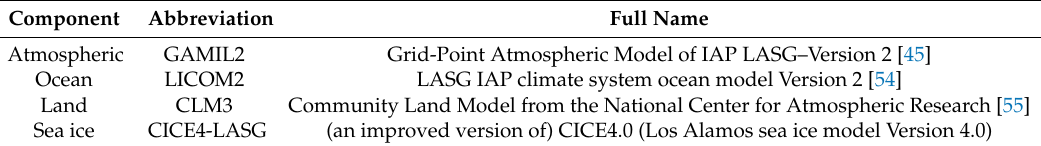
Table 1. Detailed information of the FGOALS-g2